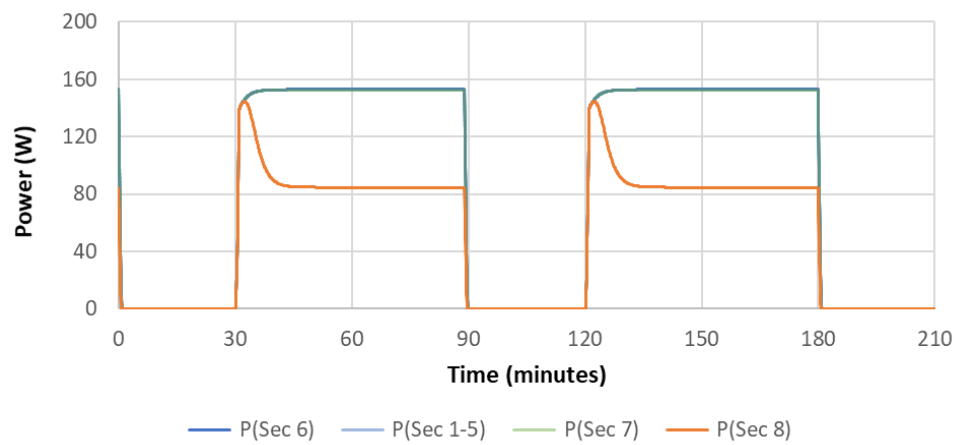
Figure 7. With S 3 R all solar array sections but section 8 supply the same output power (section 8 has a relevant decrease in Voc, whereas minor differences among Voc of sections 1 – 7 exist, so that the curves are superimposed).